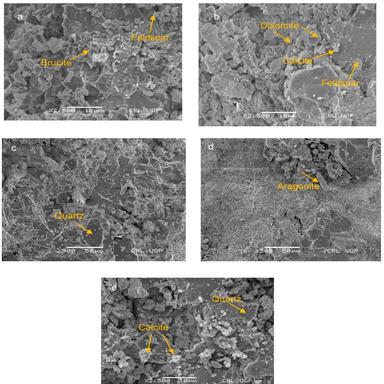
SEM Micrographs of Stone Samples: a) S2; b) S3; c) S4; d) S7; e) S8.